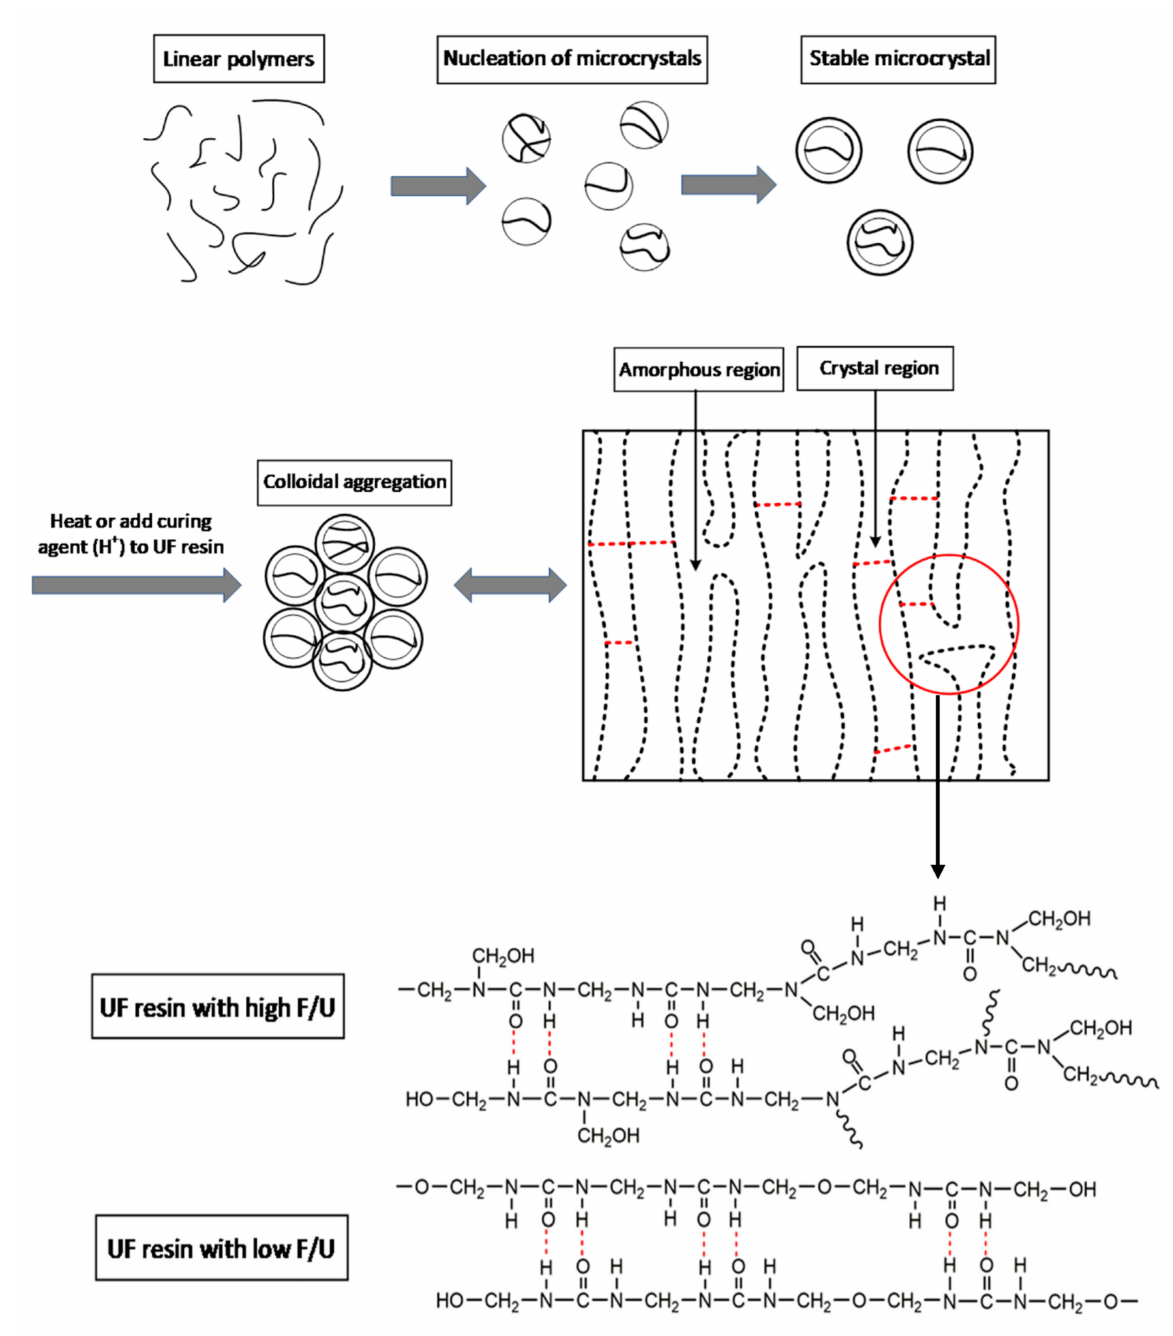
Figure 14. Possible growth methods of UF resin crystals or spherical